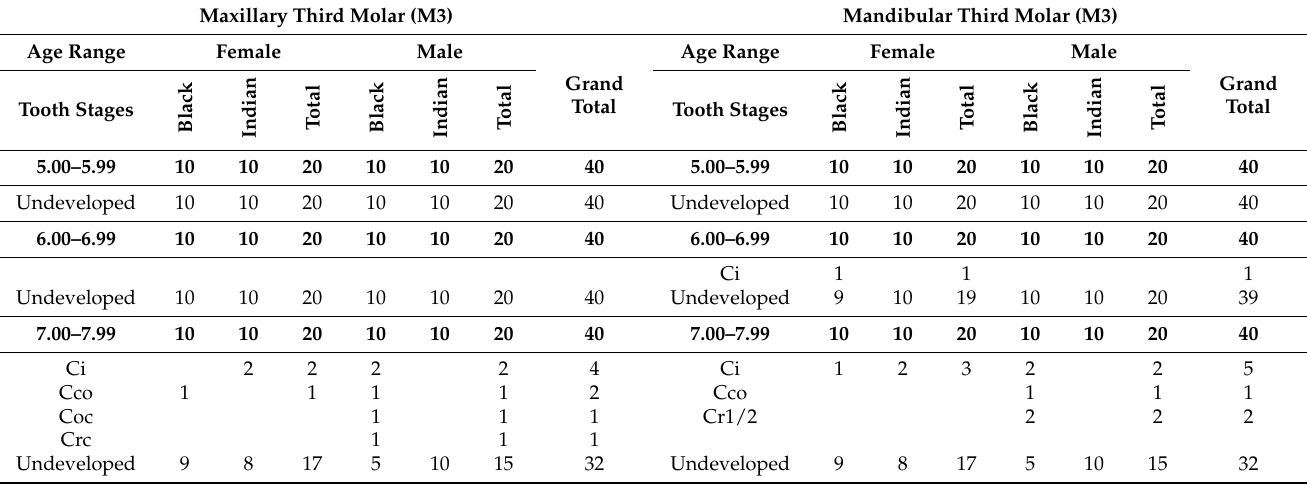
Table A8. Frequencies of the tooth development stages of the third molar for the SA Black and Indian population